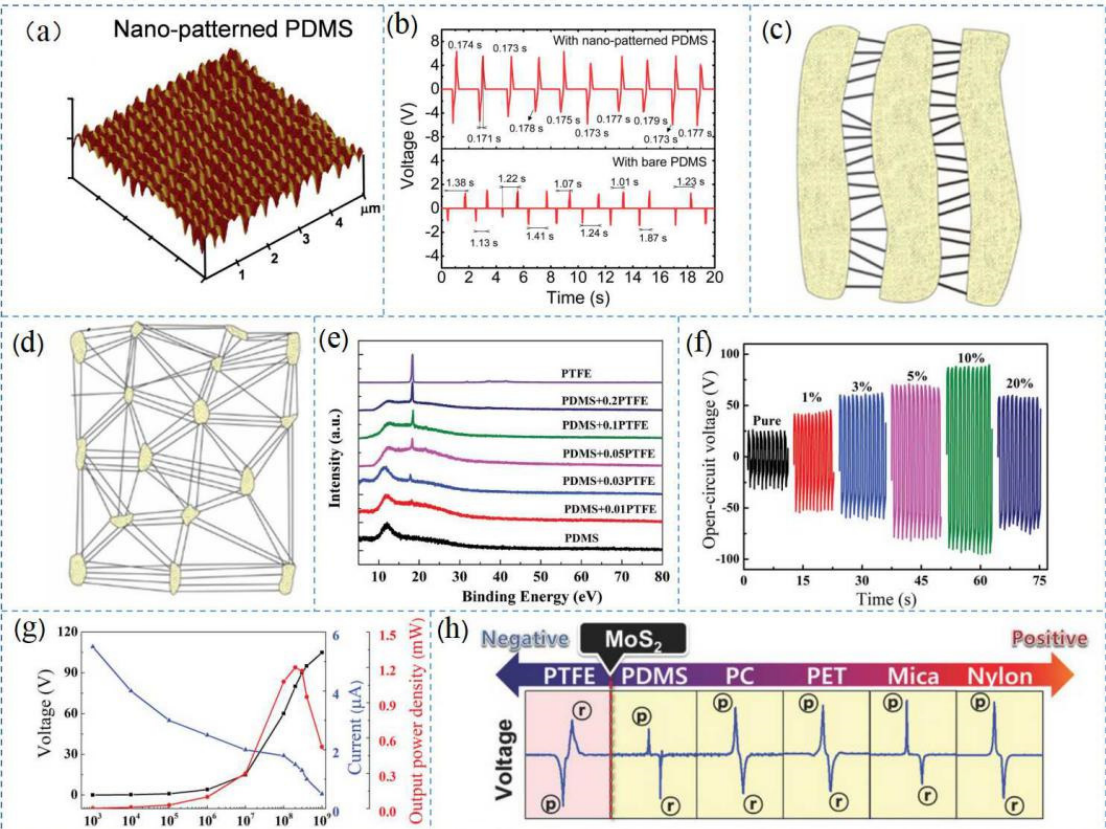
Figure 4. Preparation and characterization of the materials. ( a ) AFM images of PDMS; ( b ) output voltages of the triboelectric nanogenerators based on PDMS. Reprinted with permission from Ref. [95]. Copyright 2014 Royal Society of Chemistry; ( c , d ) PTFE structures during preparation. Reprinted with permission from Ref. [96]. Copyright 2018 Journal of Membrane Science; ( e ) XRD patterns of the PDMS-PTFE films; ( f ) output voltages of the PDMS-PTFE films; ( g ) relationship between output performance of the PDMS-PTFE films and the external load. Reprinted with permission from Ref. [81]. Copyright 2019, Advanced Electronic Materials; and ( h ) output voltage of the triboelectric series of materials. Reprinted with permission from Ref. [31]. Copyright 2018 Advanced Materials.